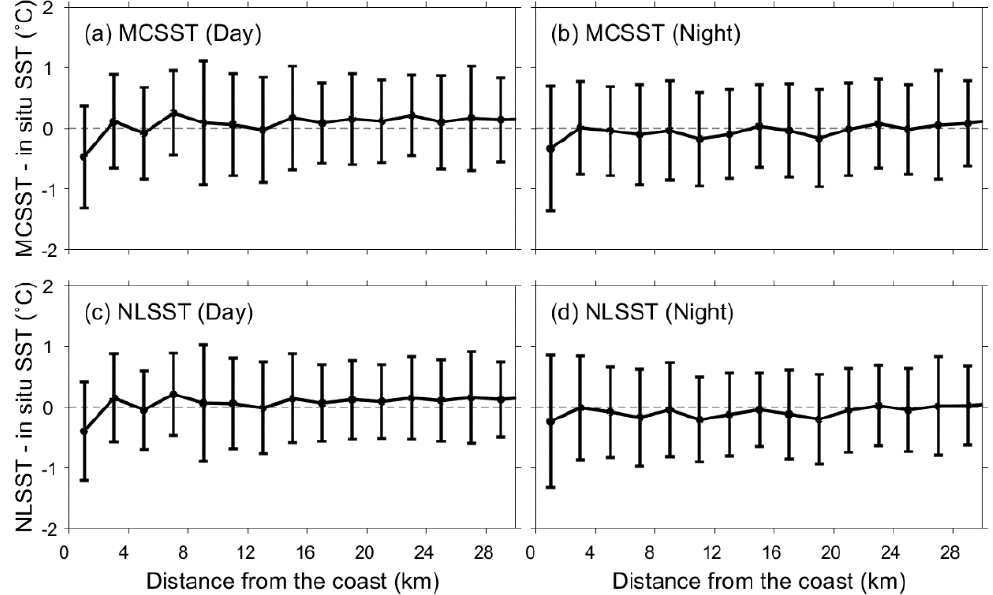
Figure 10. A plot of averaged MCSST errors during the ( a ) daytime and ( b ) nighttime and NLSST errors during the ( c ) daytime and ( d ) nighttime as a function of distance from the coast (km). The error bars indicate the standard deviation of SST errors in each interval.